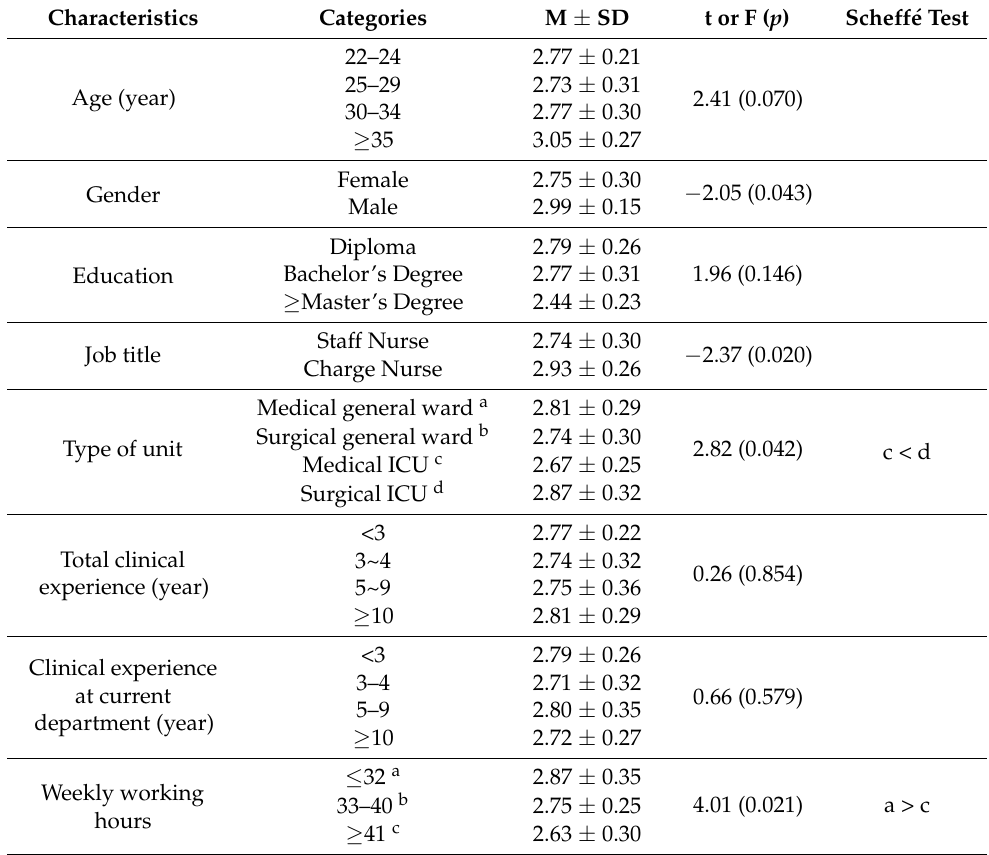
Table 4. Differences in alarm management practice according to general characteristics (N =